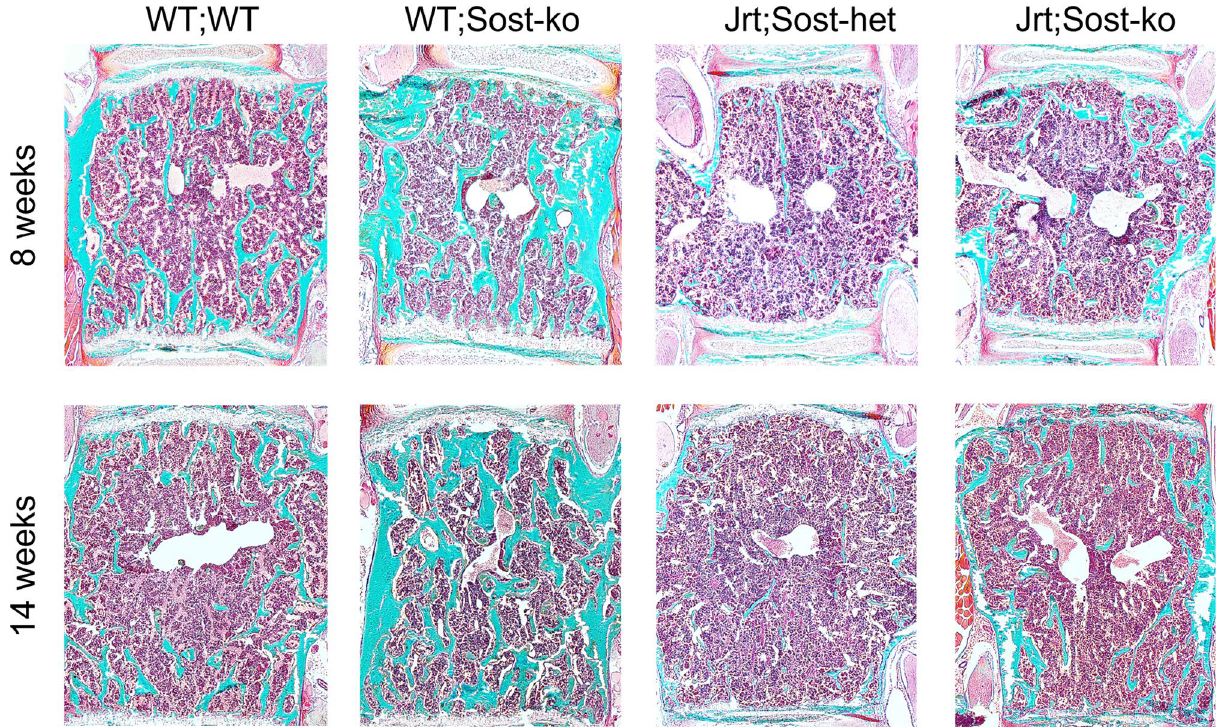
Figure 4. Histology of vertebral bones. Histological longitudinal sections of lumbar vertebra stained with Goldner’s trichrome staining at 8 and 14 weeks of age. Mineralized bone appears blue, unmineralized bone pink and bone marrow